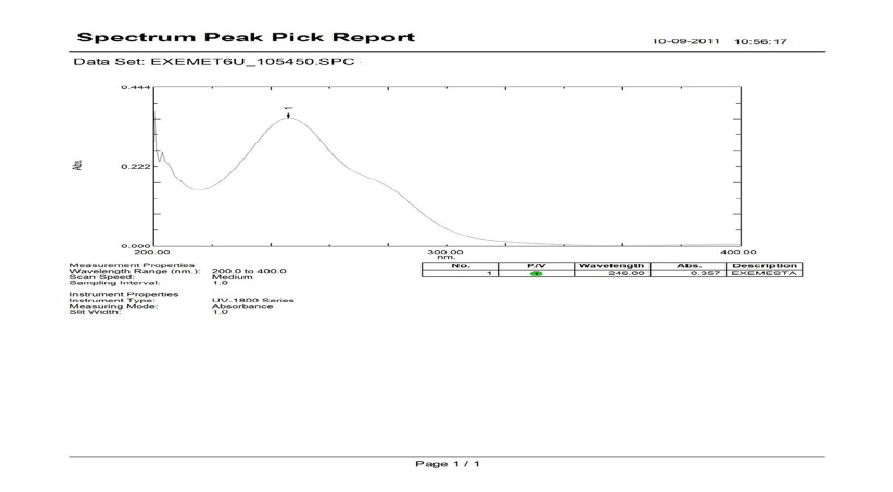
Figure 1. Absorption Maxima of Standard